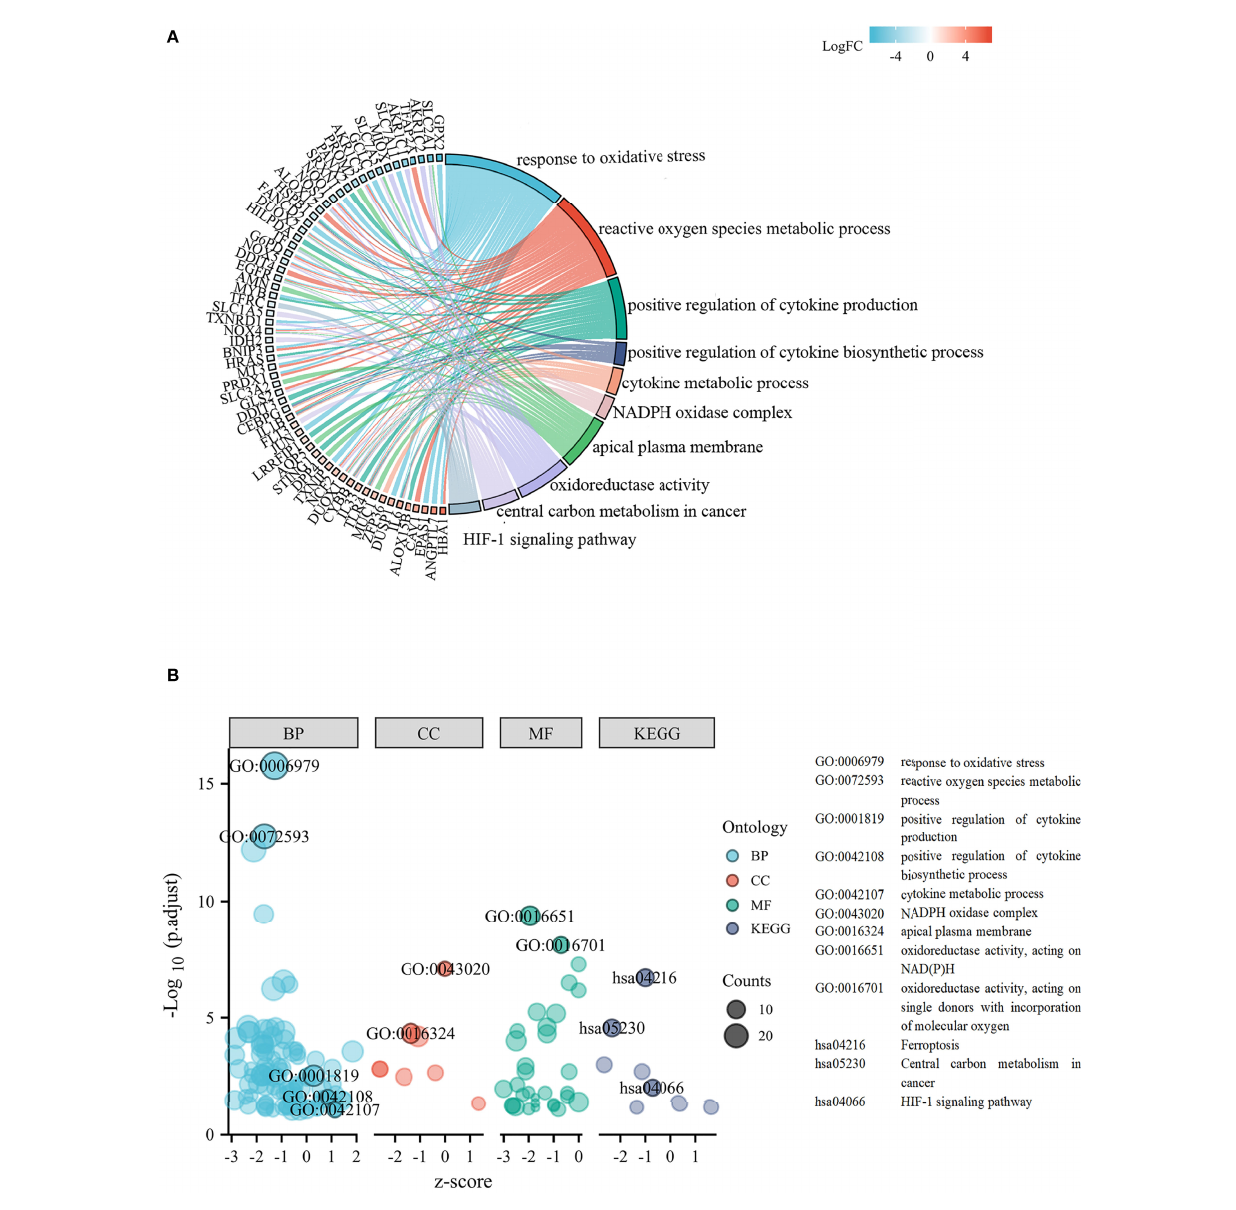
FIGURE 3 | Functional analysis based on the differentially expressed FRGs. (A) Chord plot of molecular function and biological process. (B) Bubble graph of molecular function and biological